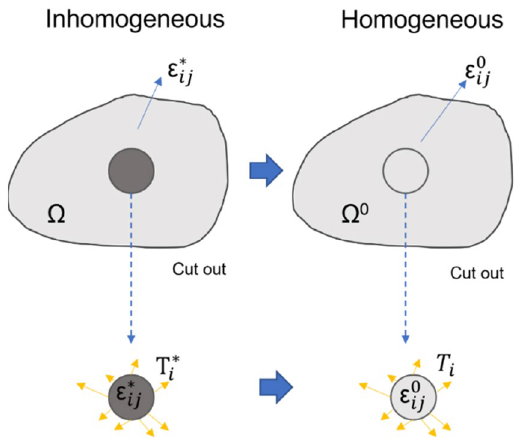
Figure 4. Schematic diagram of the principle of equivalent eigenstrain of transforming inhomogeneous problem to a virtual homogeneous